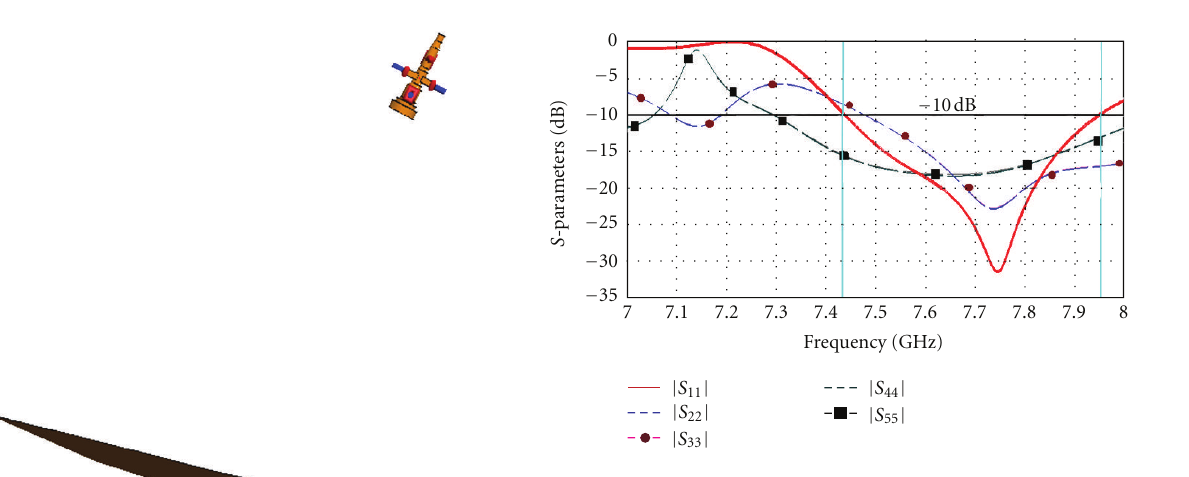
Figure 13: Reflection coe ffi cient magnitude of the o ff set reflector antenna with triple-mode